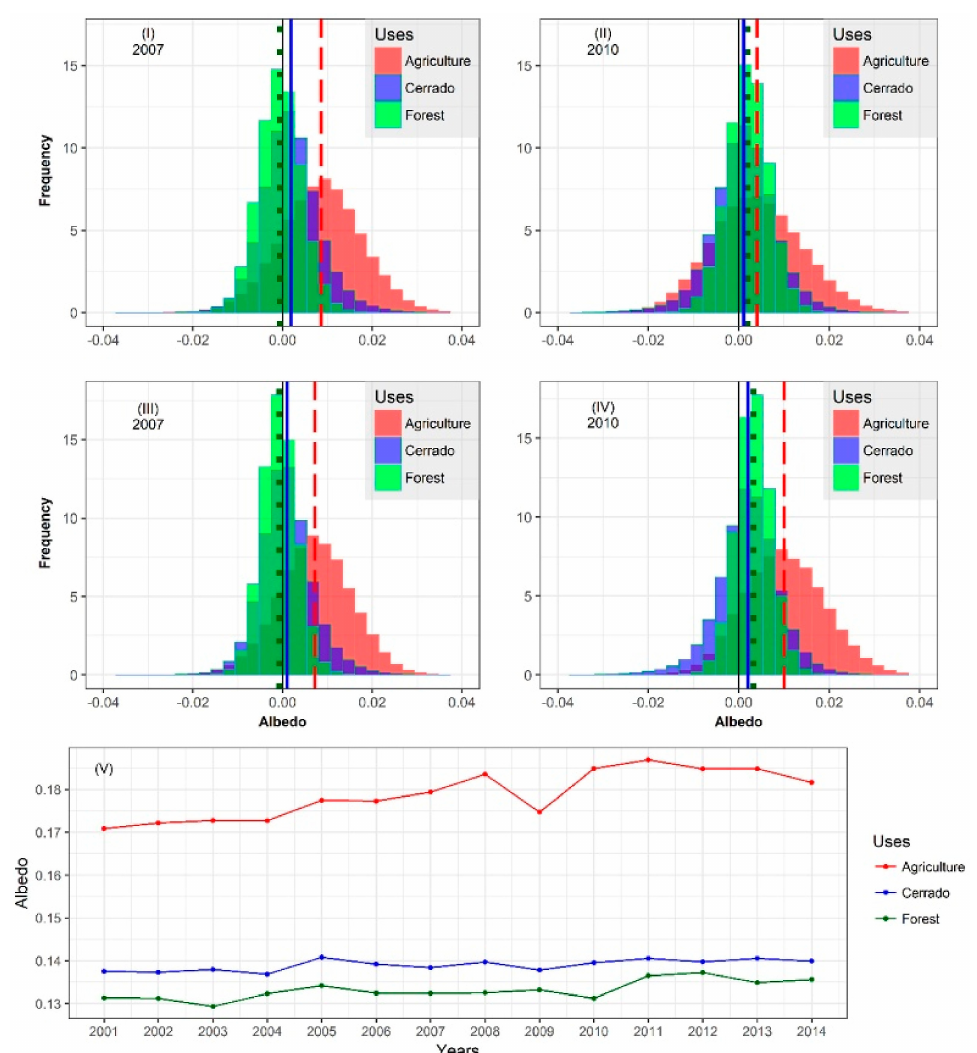
Figure A2. Histograms of the variation in the albedo of the principal land cover types in the Brazilian state of Mato Grosso during the drought events of 2007 and 2010. The dotted lines (green = forest; blue = savanna; red = cropland) represent the means recorded in each type of land cover. In graphs ( I , II ), ∆ e is the di ff erence between the mean for the year of extreme drought ( Ae ) and the biannual mean ( b ). In graphs ( III , IV ), ∆ e is the di ff erence between the mean for the year of extreme drought ( Ae ) and the historical mean ( b ). Graph ( V ) shows the variation in the albedo between 2001 and